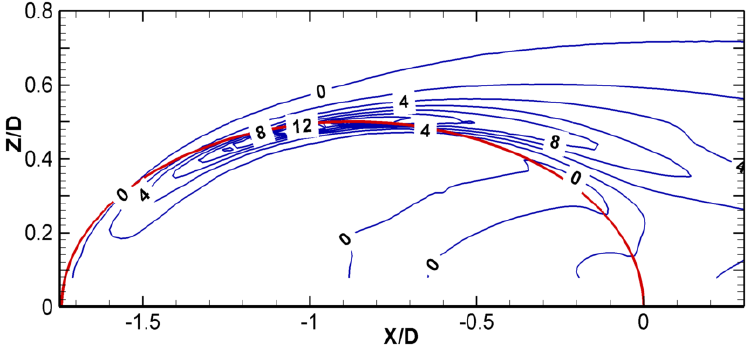
Figure 9. Contours of ω x above the exit plane in FSIT ( Y/D = 0.1).